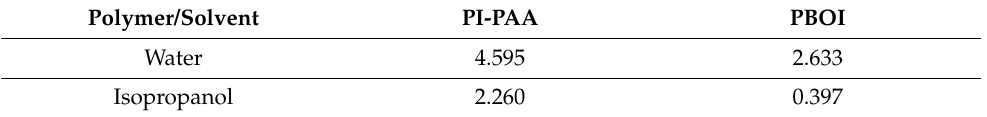
Table 3. Diffusion coefficients of water and isopropanol, calculated in PI-PAA and PBOI (10 − 4 Å 2 /ps).